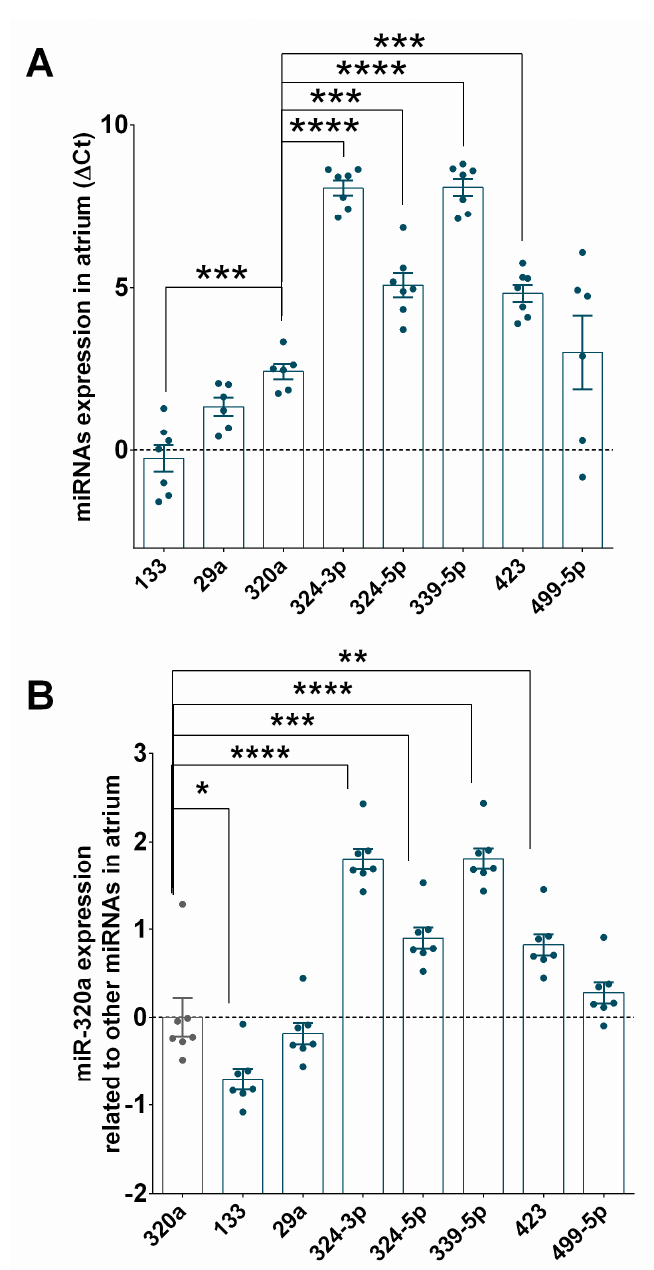
Figure 8. miR-320a is highly expressed in the atrium of patients with heart failure (HF) of ischaemic origin. (A) DeltaCt represents the level of Ct of different miRNAs compared to that of the endogenous control in the atrium of HF patients ( n = 7). (B) Levels of expression of miR-320a related to the expression of the other miRNAs shown as fold change in logarithmic scale in the atrium of failing heart. Values are presented as the means ± SEM. Significance is indicated by (*) for p < 0.05, (**) for p < 0.01, (***) for p < 0.001), and (****) for p < 0.0001. Ordinary one-way ANOVA with multiples comparisons using T-test without correction (Fisher’s LSD test) was performed.